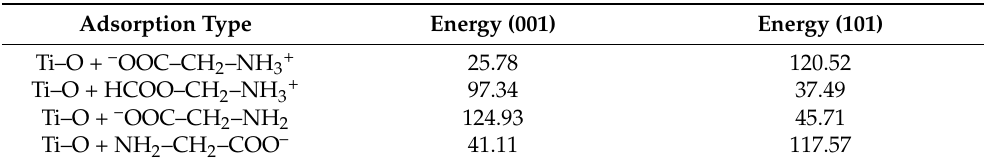
Figure 8. Adsorption model of three dissociated forms of glycine on anatase (TiO 2 ) with exposed (001) facets. ( a ) zwitterionic COO – ; ( b ) positive dissociated ions of –COOH; ( c ) negative dissociated ions of –COO – ; ( d ) negative dissociated ions of –NH 2 . Table 1. Adsorption energy of different dissociated forms of glycine on the two kinds of anatase (TiO 2 ) (unit: kJ/mol).